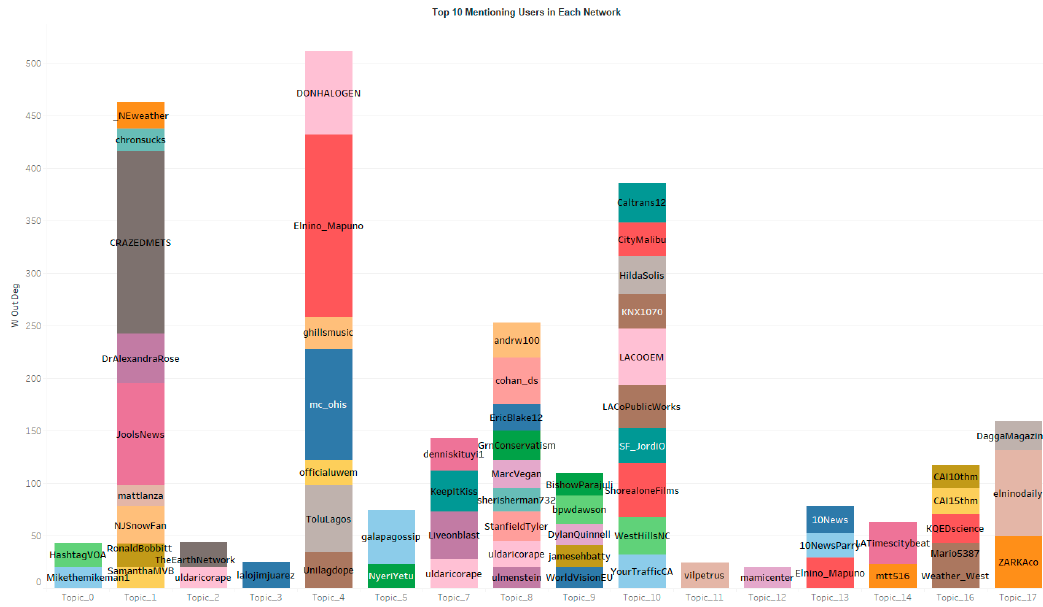
Figure 8. The top 10 mentioning users.